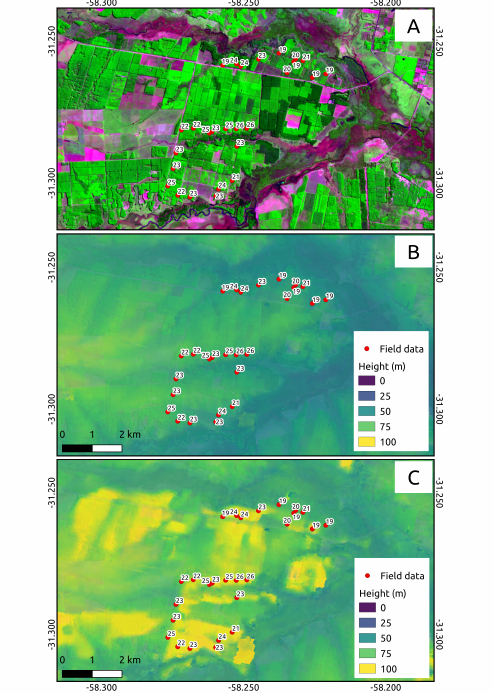
Figure 7. Visual results of the orbital correction for Pair 1 (HH channel). A: Forested parcels in the study area. B: Resulting DSM with no orbital correction. C: DSM obtained after applying orbital correction (Note: DSM elevation is expressed in meters above the ellipsoid, and field data express the tree height above the